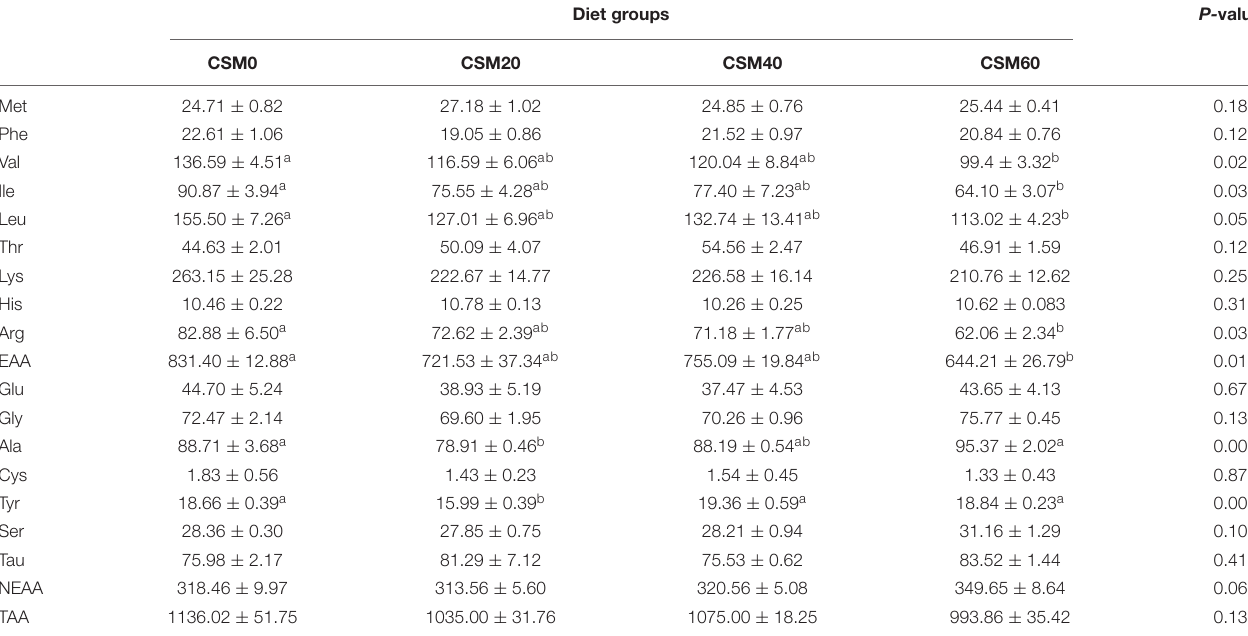
TABLE 7 | The free amino acids concentration after golden pompano feed with different diets in the plasma ( µ